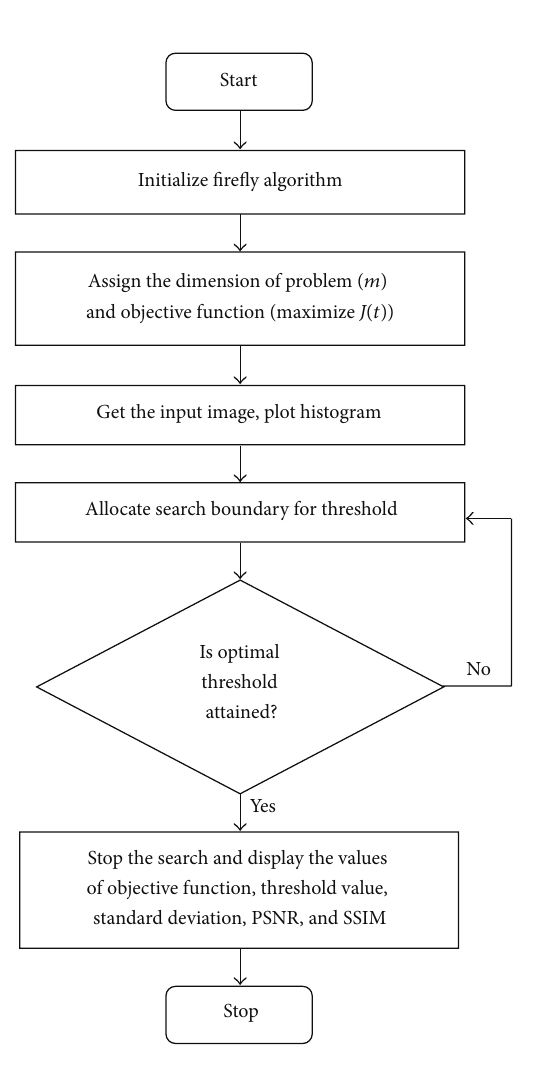
Figure 4: Flow chart of proposed method.